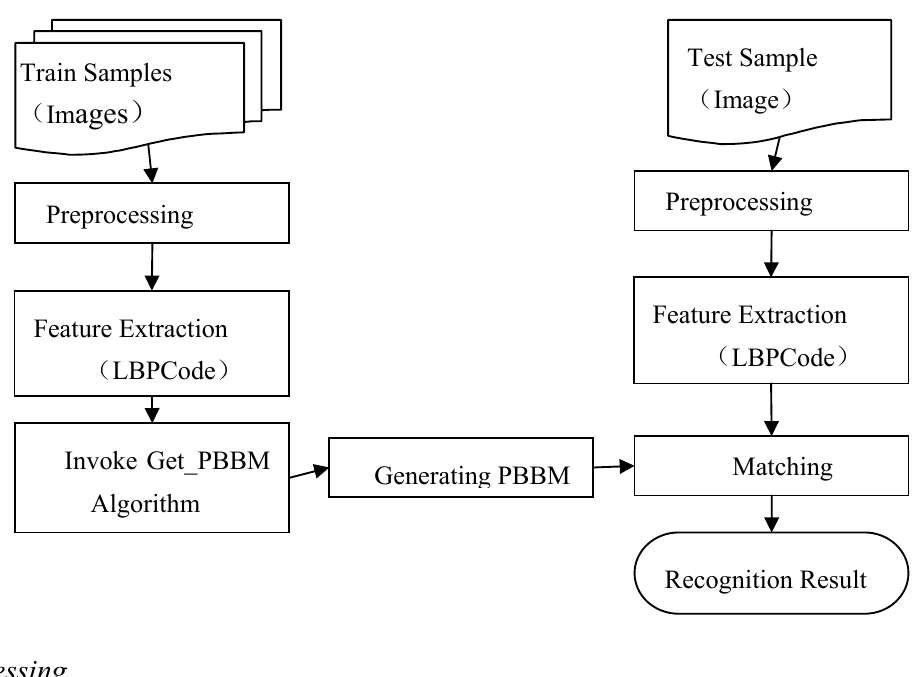
Figure 3. Framework of the proposed